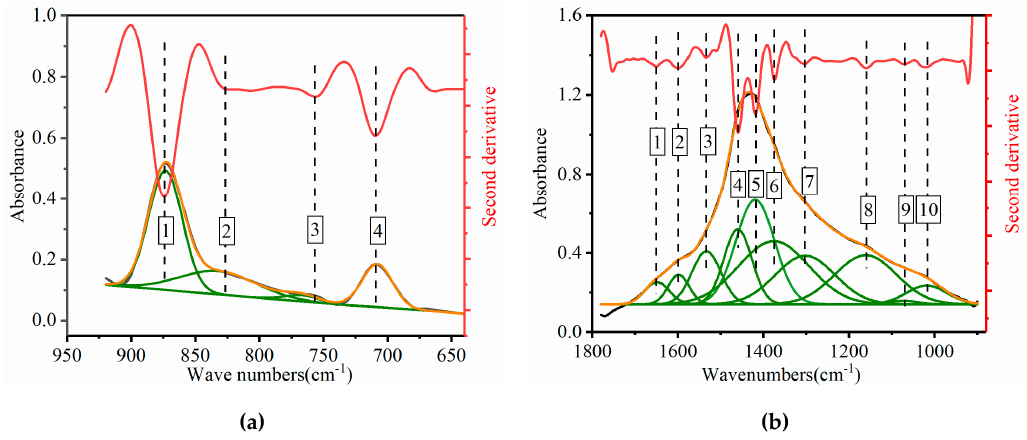
Figure 8. Graph showing the curve-fitting of the overlapping bands for the mastics. ( a ) 900–600 cm − 1 − 1 wave wave numbers; ( b ) 1780–900 cm − 1 wave numbers. wave numbers; ( b ) 1780–900 cm